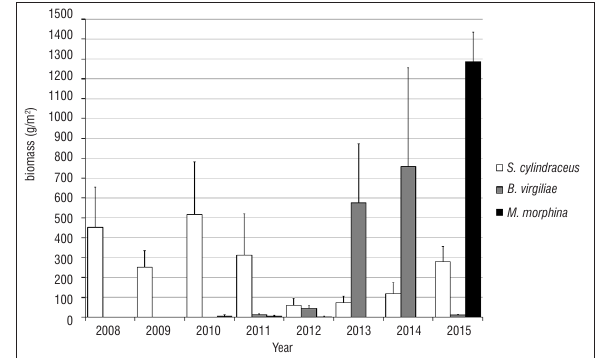
Figure 4: Estimated average biomass (fresh weight, g/m 2 ) of Solen cylindraceus , Brachidontes virgiliae and Meretrix morphina in Lake St Lucia between 2008 and 2015. Error bars show